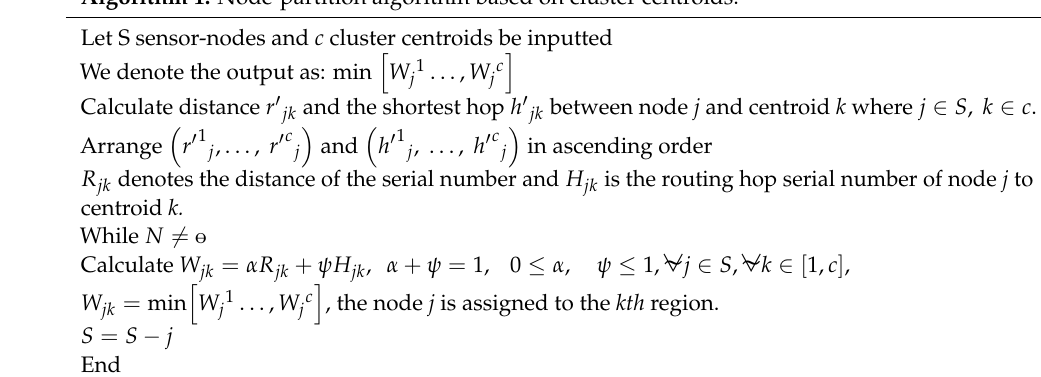
Algorithm 1: Node-partition algorithm based on cluster centroids.